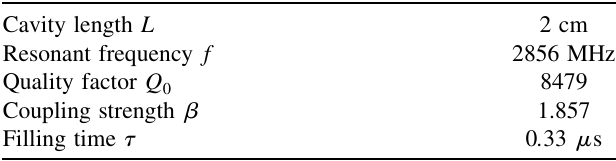
FIG. 12. Beam current and backward wave